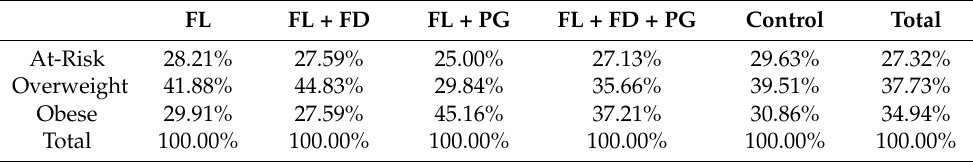
Table 2. Percent of Children in each BMI Group for Each Condition at Wave